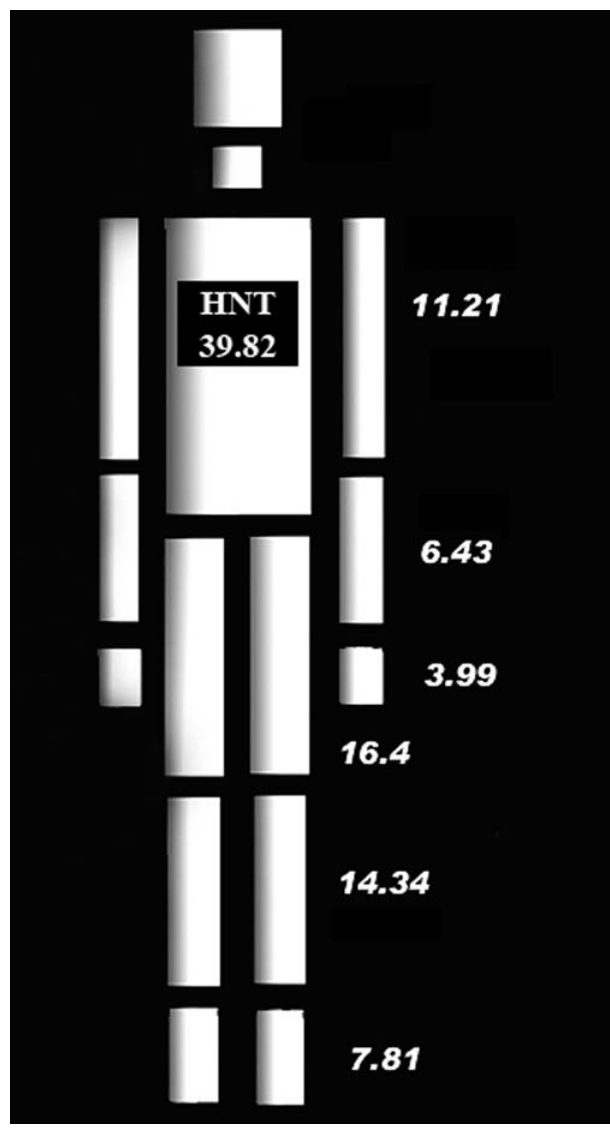
Figure 1. Model of the human body used in the segmented method. Numeric values represent the mean percentages of total body surface area represented by the various body segments based on the sample employed in the study reported here. Each segment is modeled as a cylinder. HNT = head, neck and trunk.